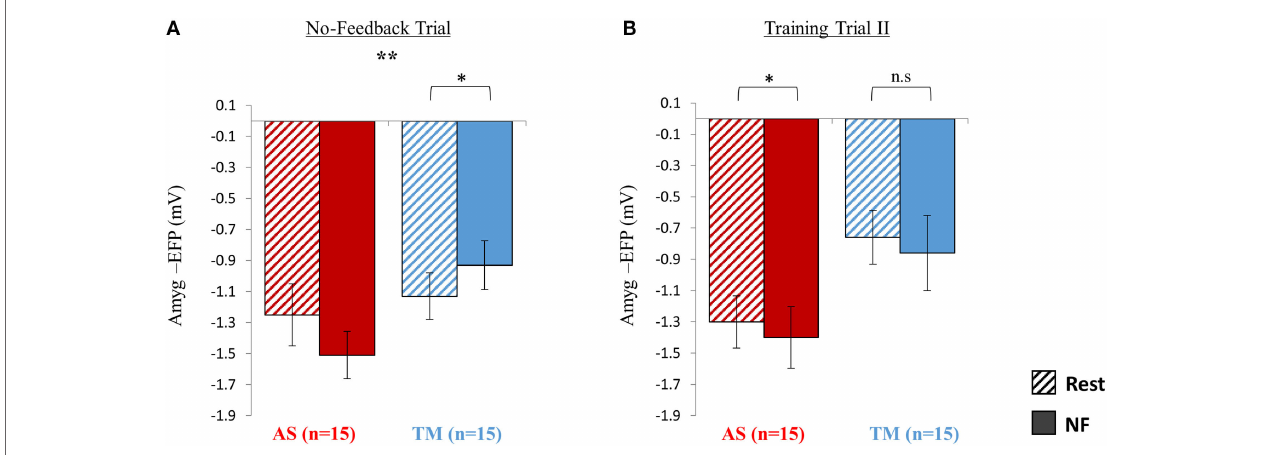
FigUre 4 | sustainability testing at session 2 . (a) At the no-feedback trial conducted at the beginning of session 2, the AS group (red) exhibited better down regulation of the amyg-EFP (NF relative to rest) compared to the TM group (blue) as indicated by a significant group by condition interaction [ F (1,28) = 9.16. p < 0.01] (B) When practicing for the second time with the same interface assigned initially, only the AS group was able to replicate the success of the first training trial. * p < 0.05, ** p <